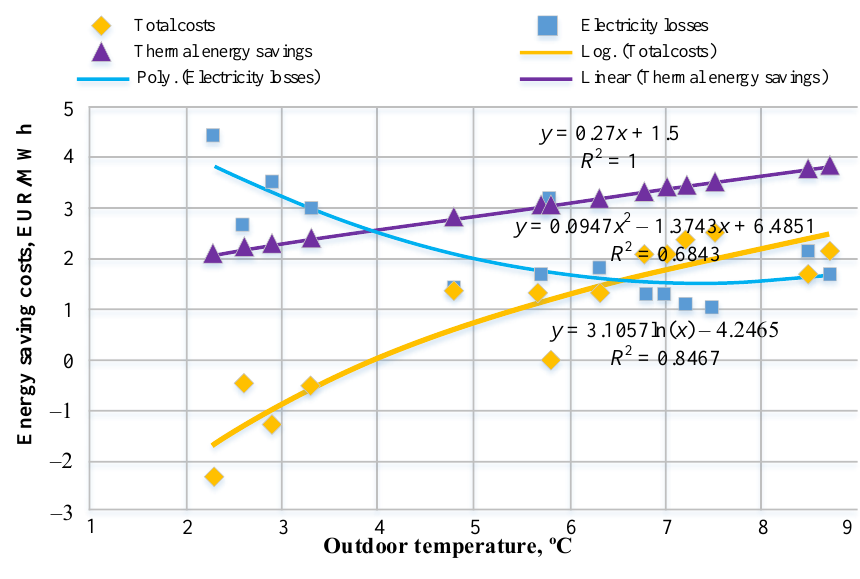
Fig. 10. Graph of cost